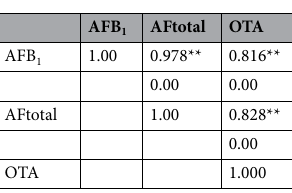
Table 8. Associations of mycotoxins (AFB 1 , AFtotal and OTA) in maize from Ashanti Region. **Correlation is significant at the 0.01 level (2-tailed).